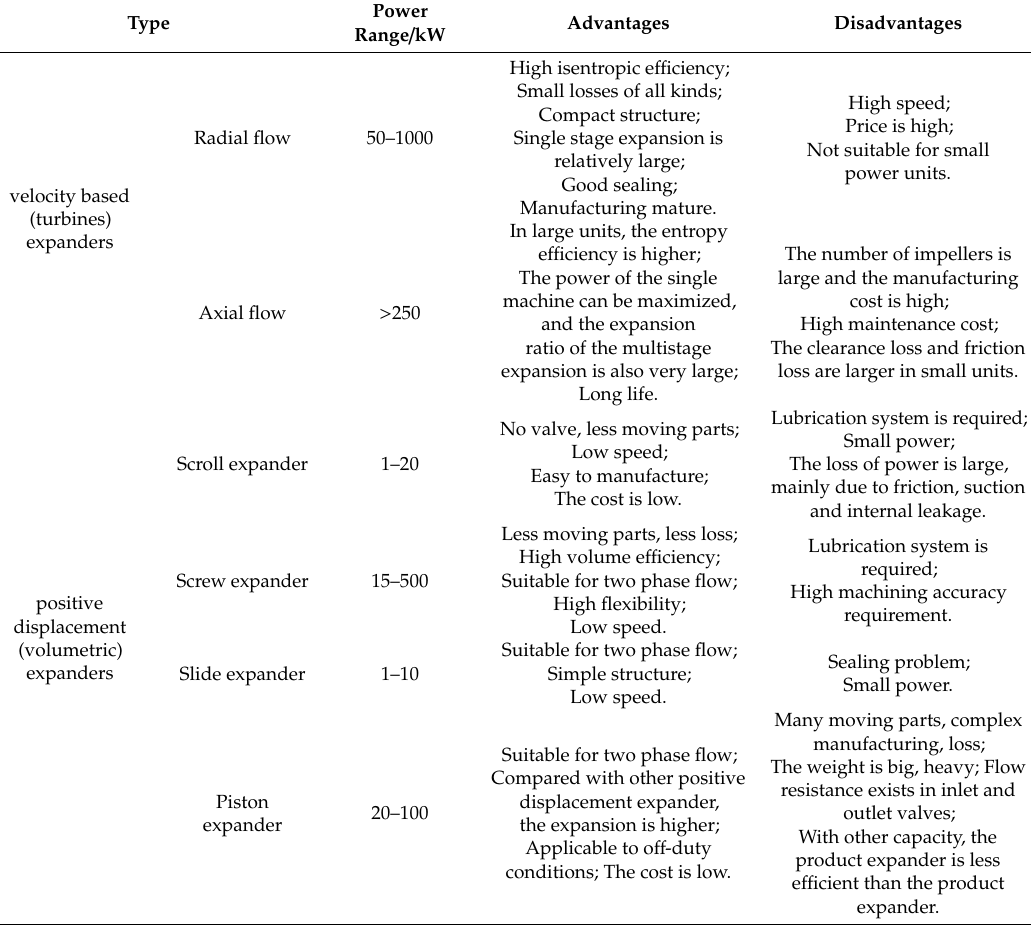
Table 2. Comparison of advantages and disadvantages of various expansion